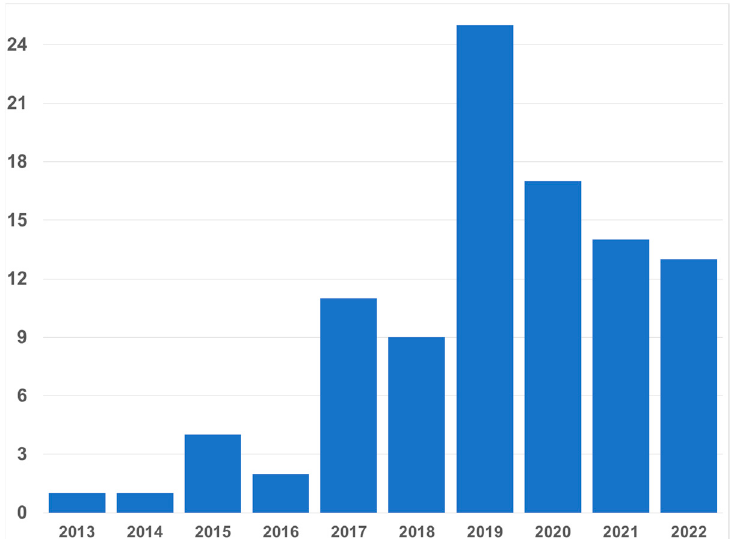
Figure 1. Yearly distribution of forensic papers about human microhaplotypes since the first in 2013 through 25 June 2022. Note that 2022 is outpacing 2021 so far. All fields were searched for “microhaplotype” or “micro-haplotype” in PubMed and in the journal Forensic Science International Genetics Supplemental Series, which is not included in PubMed.